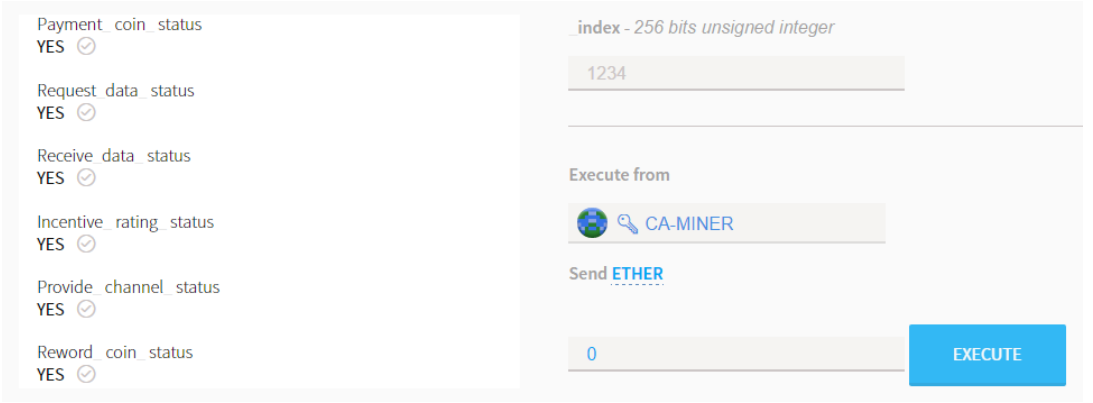
Figure 9. Status changes after smart contract completes in